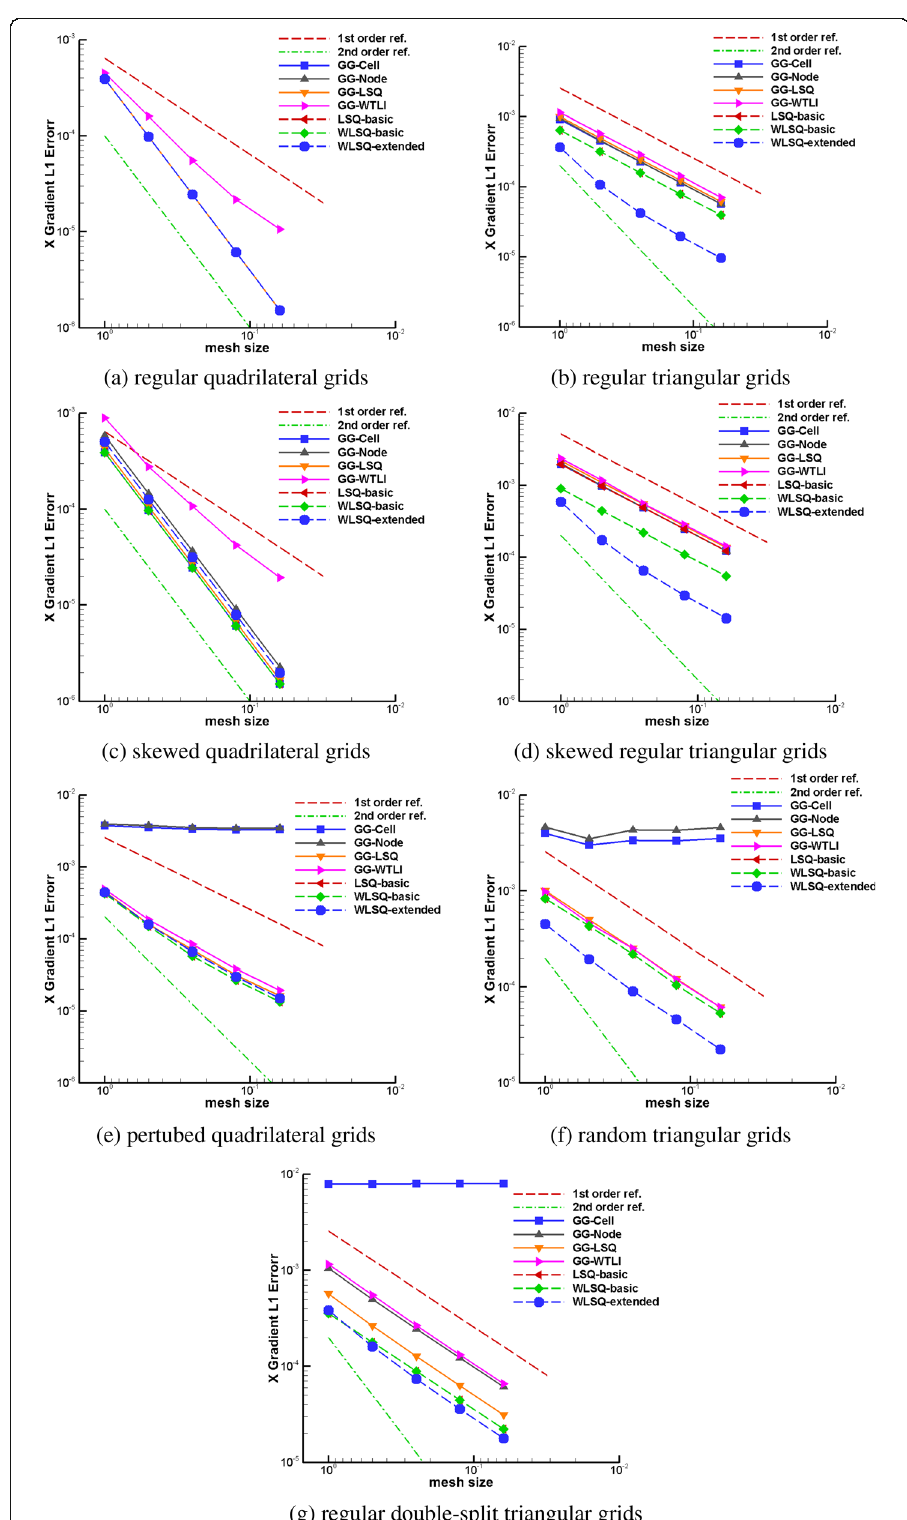
Fig. 9 Convergence of x -direction gradient of different grids and different reconstruction methods. a Regular quadrilateral grids. b Regular triangular grids. c skewed quadrilateral grids. d skewed regular triangular grids. e Perturbed quadrilateral grids. f Random triangular grids. g Regular double-split triangular